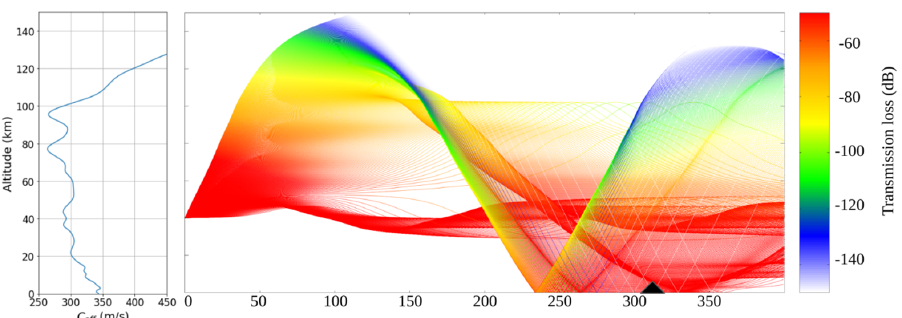
Figure 13. ( left ) Ground-to-space (G2S) effective sound speed profile and ( right ) 2D ray-tracing simulation results, indicating that ground-based sensing at OSU1 (marked with the black triangle) was likely.